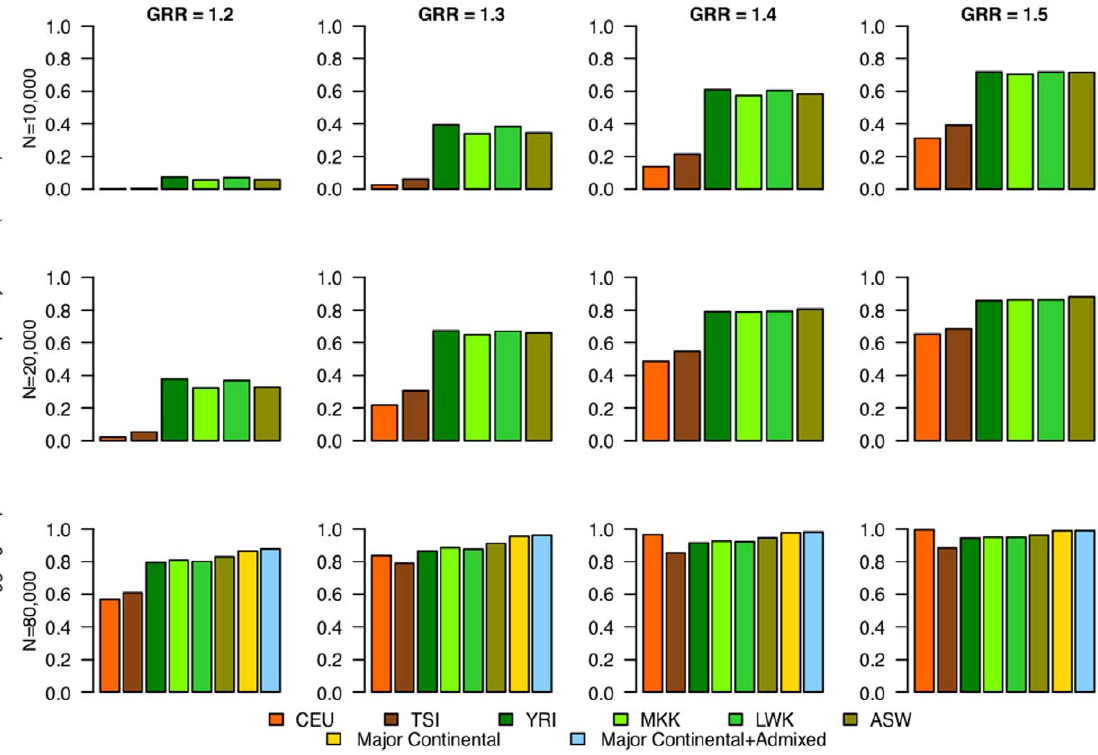
Figure 1. Power to detect association for lower-frequency alleles ( # 5%) in CEU based on HapMap 3 data. Power is given for various individual population panels (CEU, TSI, YRI, MKK, LWK, and ASW), a panel with major continental representation (CEU + CHB + YRI) and a cosmopolitan panel with major continental representation and admixed populations (GIH, MXL, and ASW) interrogated in phase 2, aggregated over those alleles that have lower frequency (1–5%) in CEU.